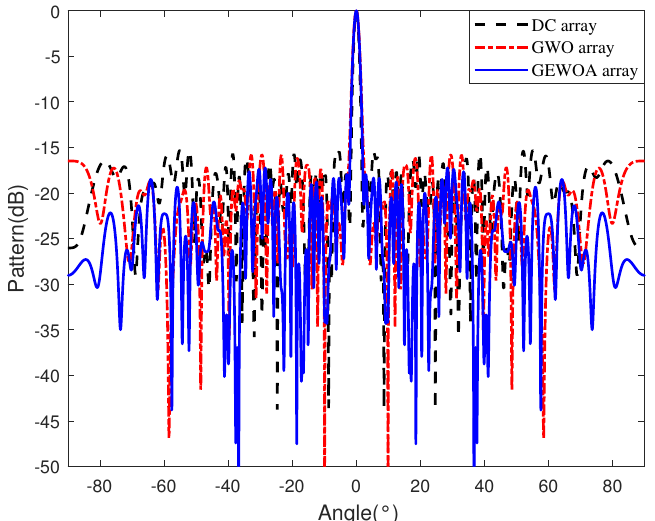
Figure 18. Beampatterns of sparse arrays designed using different methods. Table 3. The PSLLs of arrays designed using different algorithms.